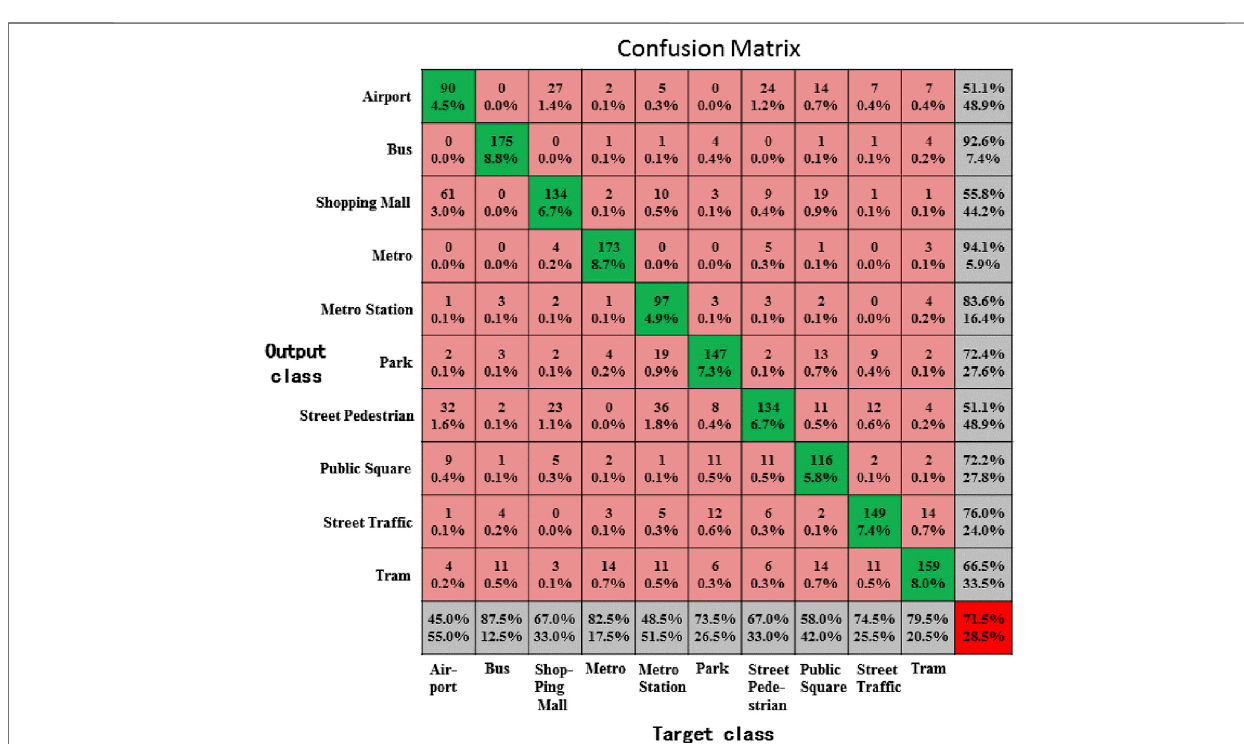
FIGURE 10 | Recognition results of basic features and HACFs features.